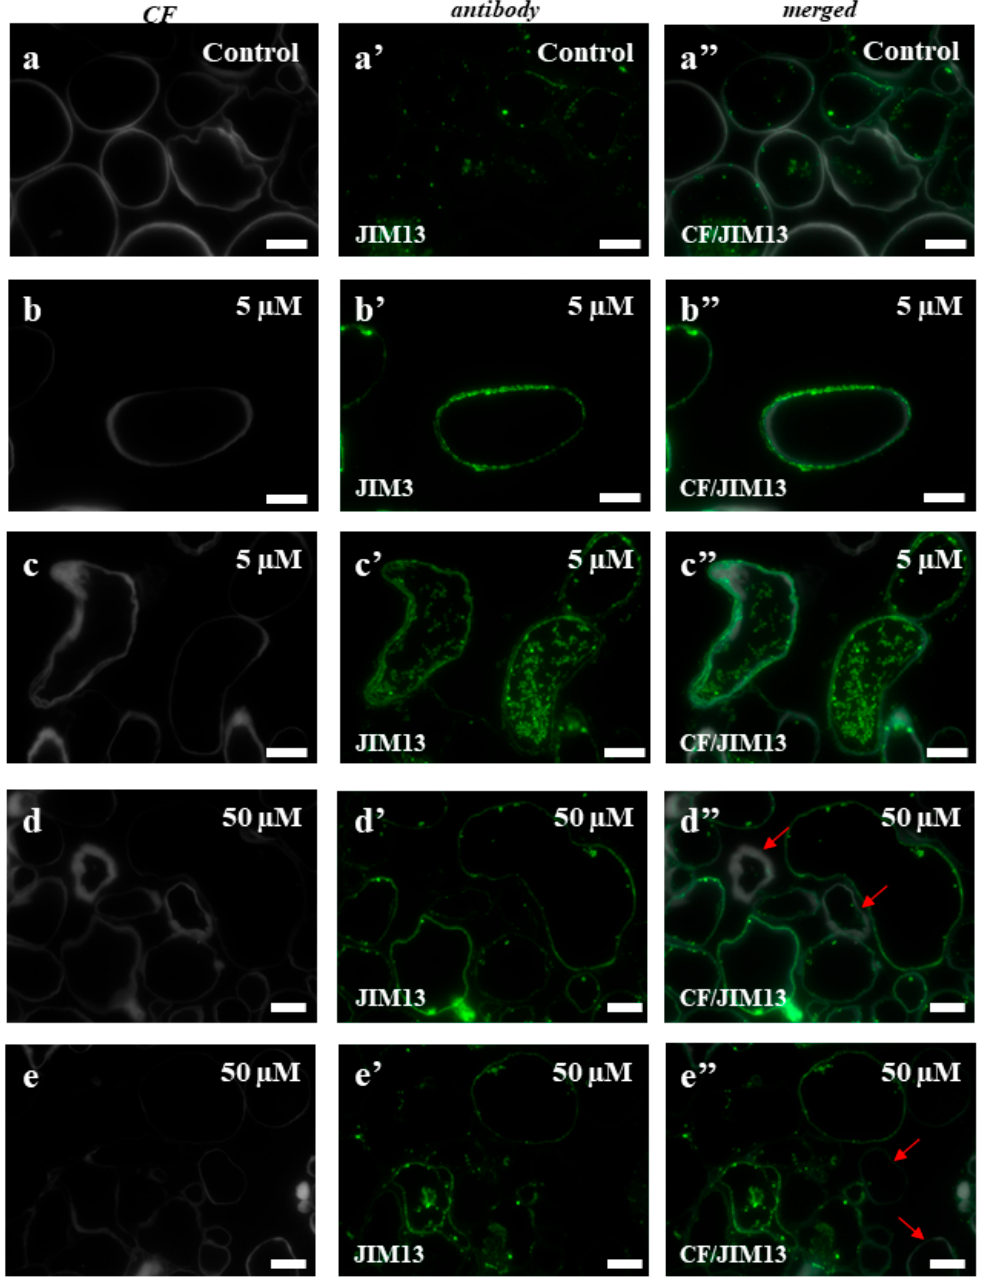
Figure 6. Immunolocalization of JIM13 in the Brachypodium callus. ( a – a” ): control callus. ( b – b” , c – c” ): callus that has been treated with 5 µ M of 5-azaC. ( d – d” , e – e” ): callus that has been treated with 50 µ M of 5-azaC. The cells with a total absence of the signals are indicated by red arrows. Scale bars, 10 µm.